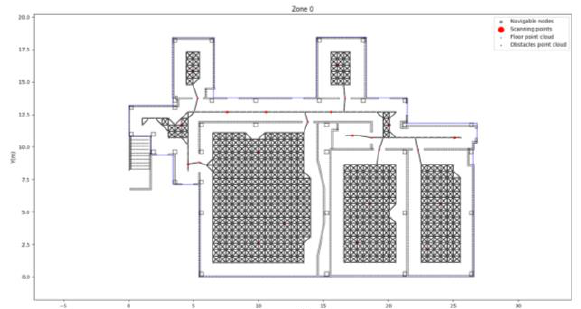
Figure 11. Graph representing the navigation space within the building.